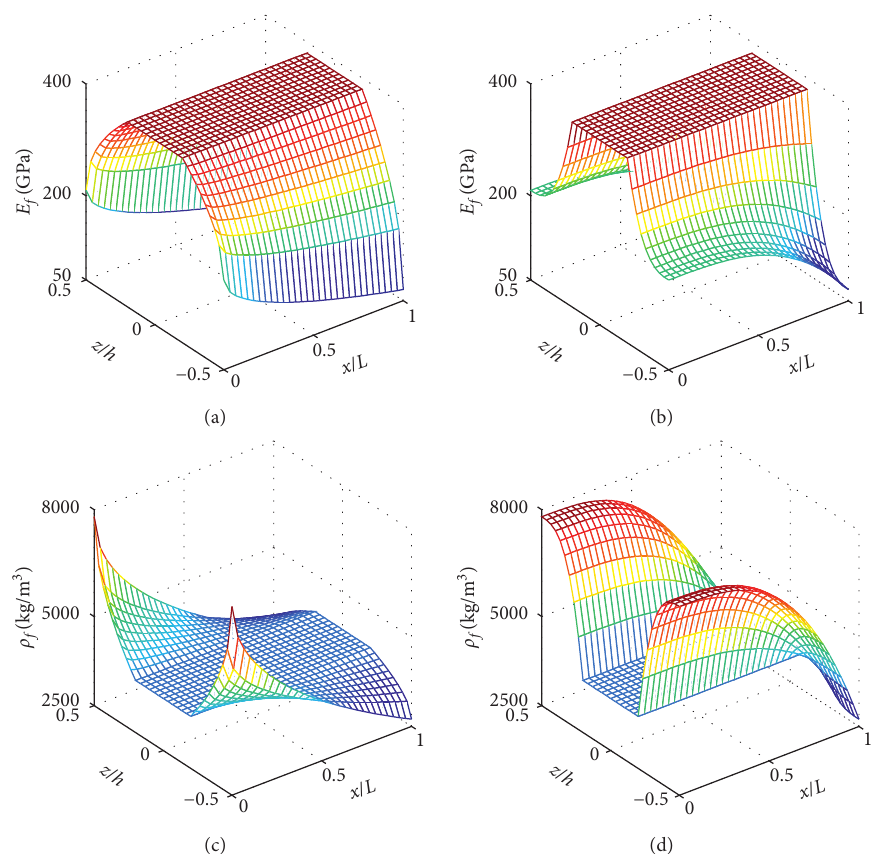
Figure 3: Variation of E (d) ρ f with n x � n z � 3.